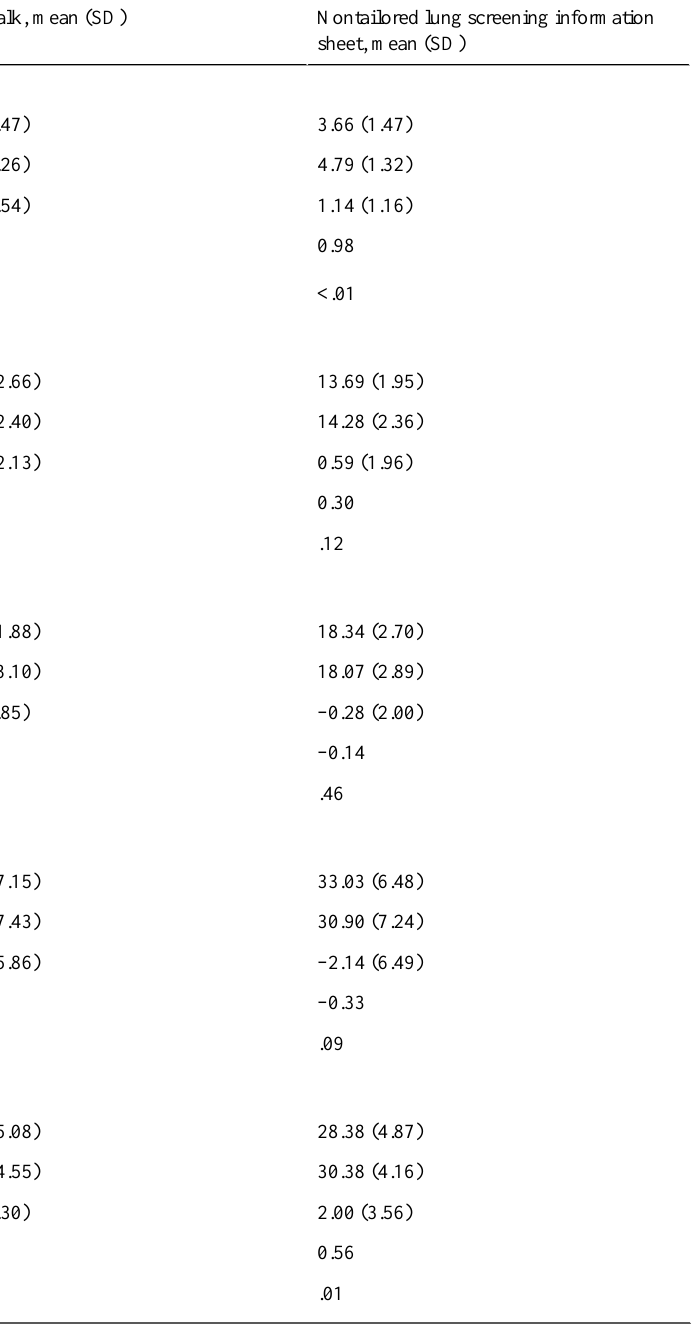
Table 2. Scores at baseline (T1) and 1-week postintervention (T2) and within-group